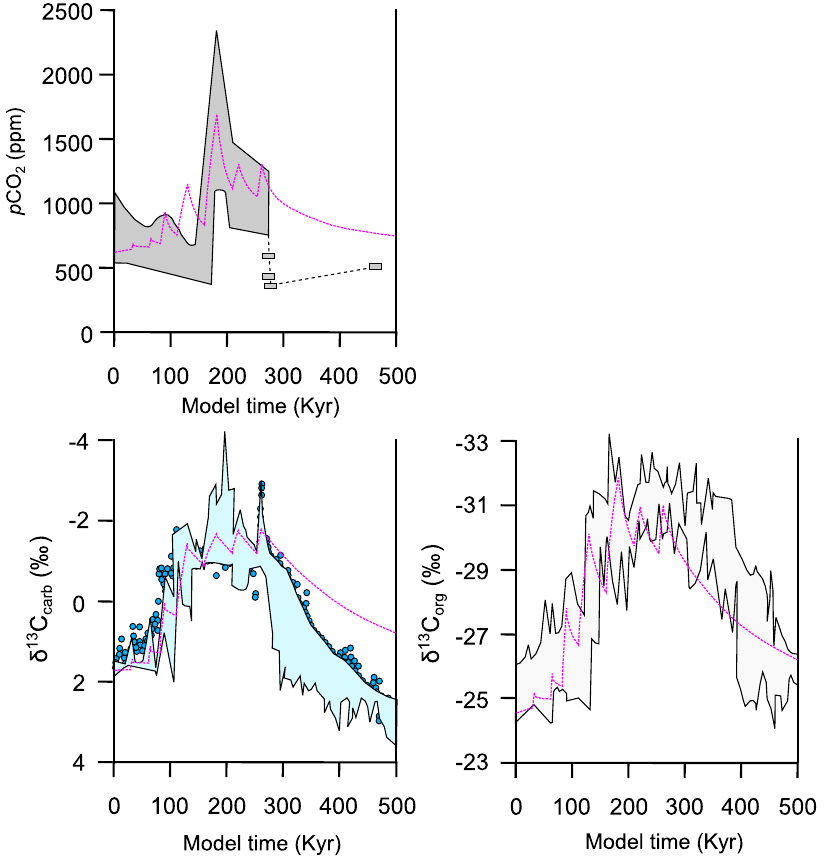
Fig. 3 Modeled p CO 2 and δ 13 C curves compared to observed Toarcian data. Model response (pink dashed lines) of δ 13 C org and δ 13 C carb of the shallow ocean (GEOCLIM epicontinental surface reservoir boxes) and atmospheric p CO 2 to a Karoo emission scenario including eight pulses of carbon release (see Table 1; Supplementary Fig. 1). Gray and blue outlines represent the range of observed Toarcian δ 13 C carb 4,5,9 , δ 13 C org 8,16,36 , and p CO 2 data 1 , which corresponds to the curves presented in Fig.